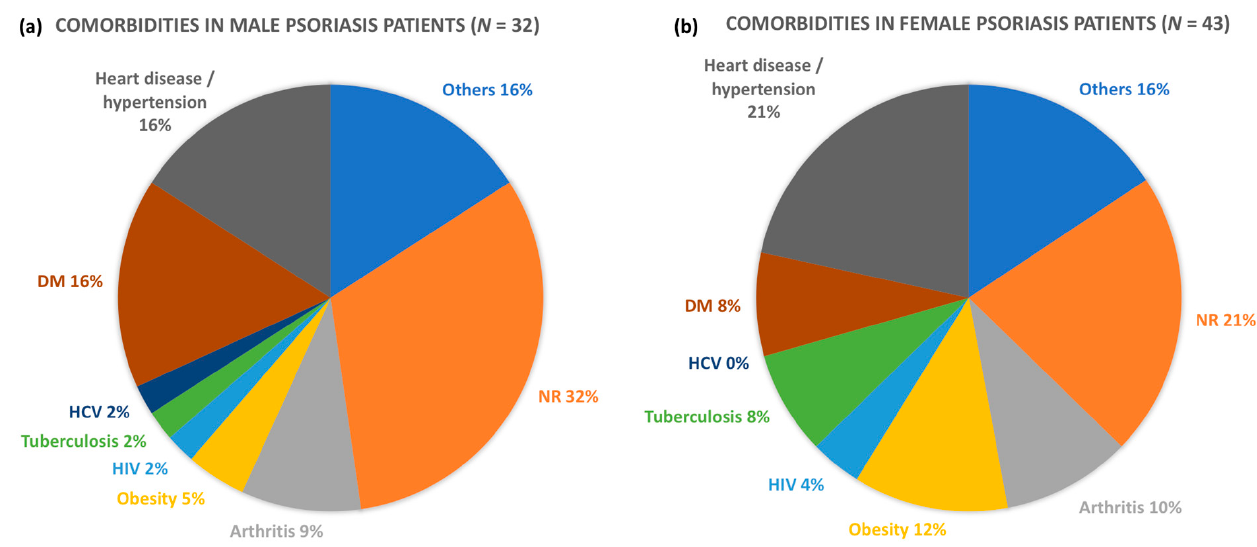
Figure 2. Comorbidities and psoriasis patients. Graphic illustration of main comorbidities reported by male ( n = 32) ( a ) and female ( n = 43) ( b ) Pso patients. DM: diabetes mellitus; HCV: hepatitis C virus infection; HIV: human immunodeficiency virus infection; NR: not related.